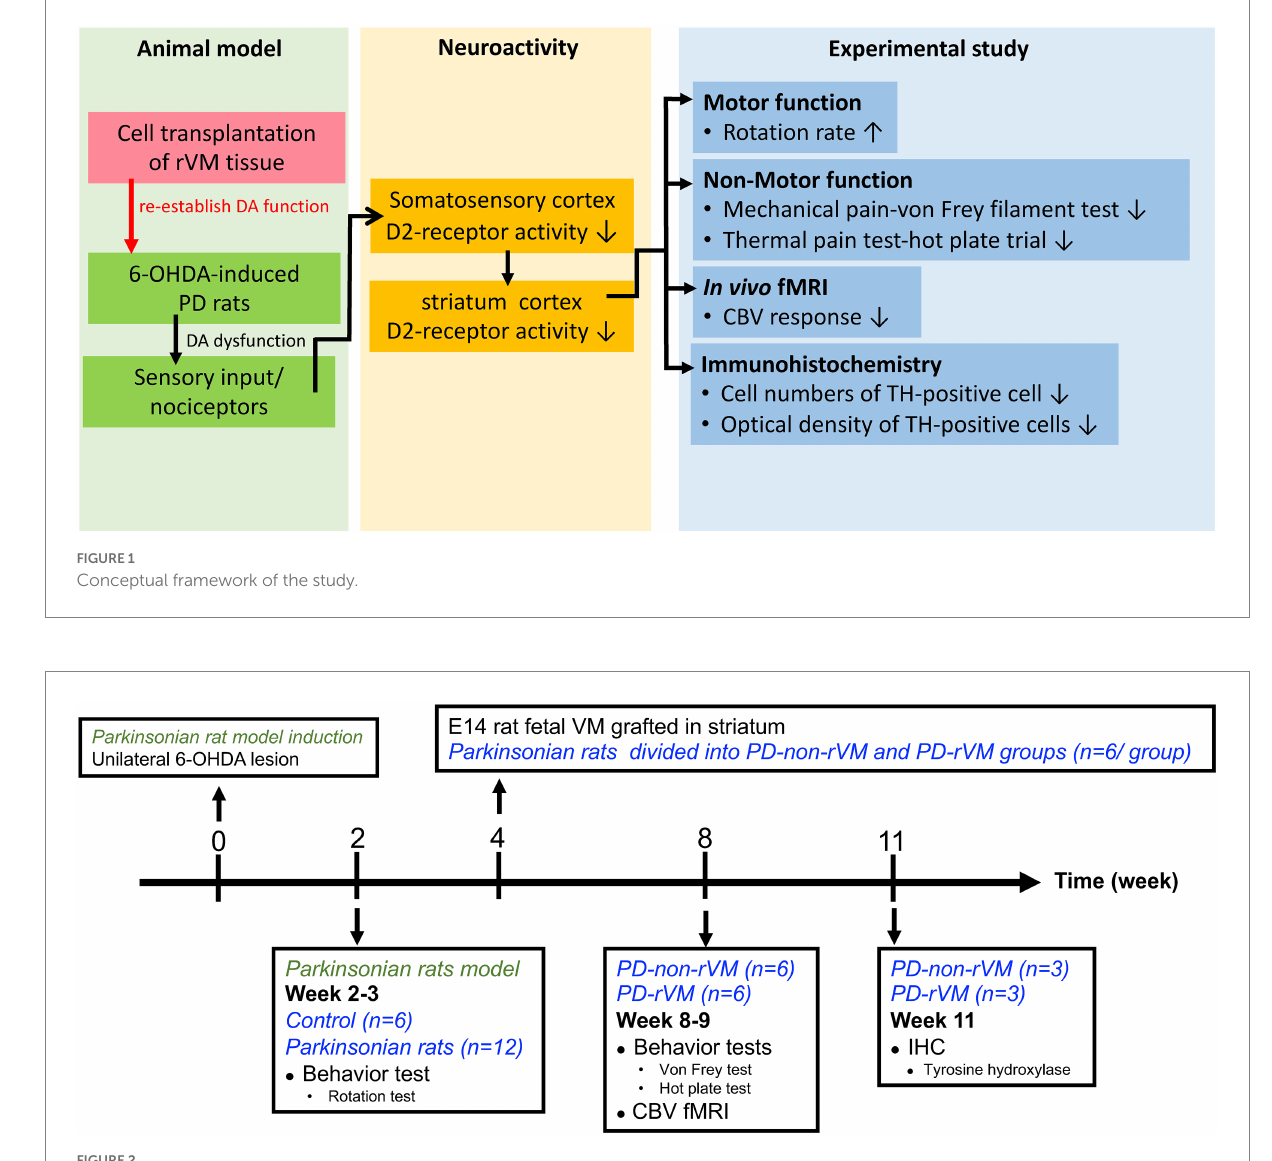
FIGURE 2 Schematic representation of the study design. Unilateral 6-OHDA lesions were induced at week 0 to establish the hemiparkinsonian model. Two weeks later, the animals were subjected to rotation tests; animals that met the PD criteria (>300 turns/h) were randomly allocated to either Group PD (without rVM treatment) or Group PD-rVM (with treatment). Group PD-rVM were transplanted with rVM tissue in week 4. All animals were subjected to behavior tests and CBV fMRI in week 8–9. Immunohistochemistry was performed in week